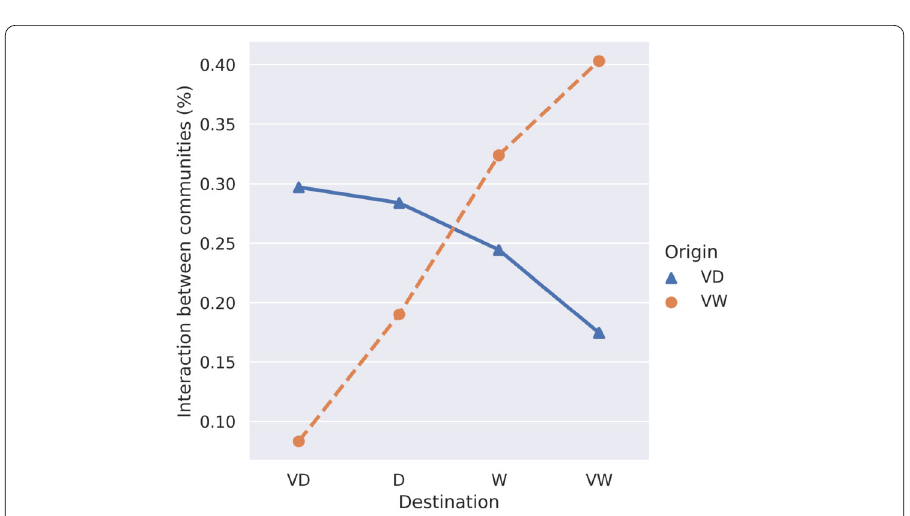
Figure 9 Trend of community VD and community VW interactions